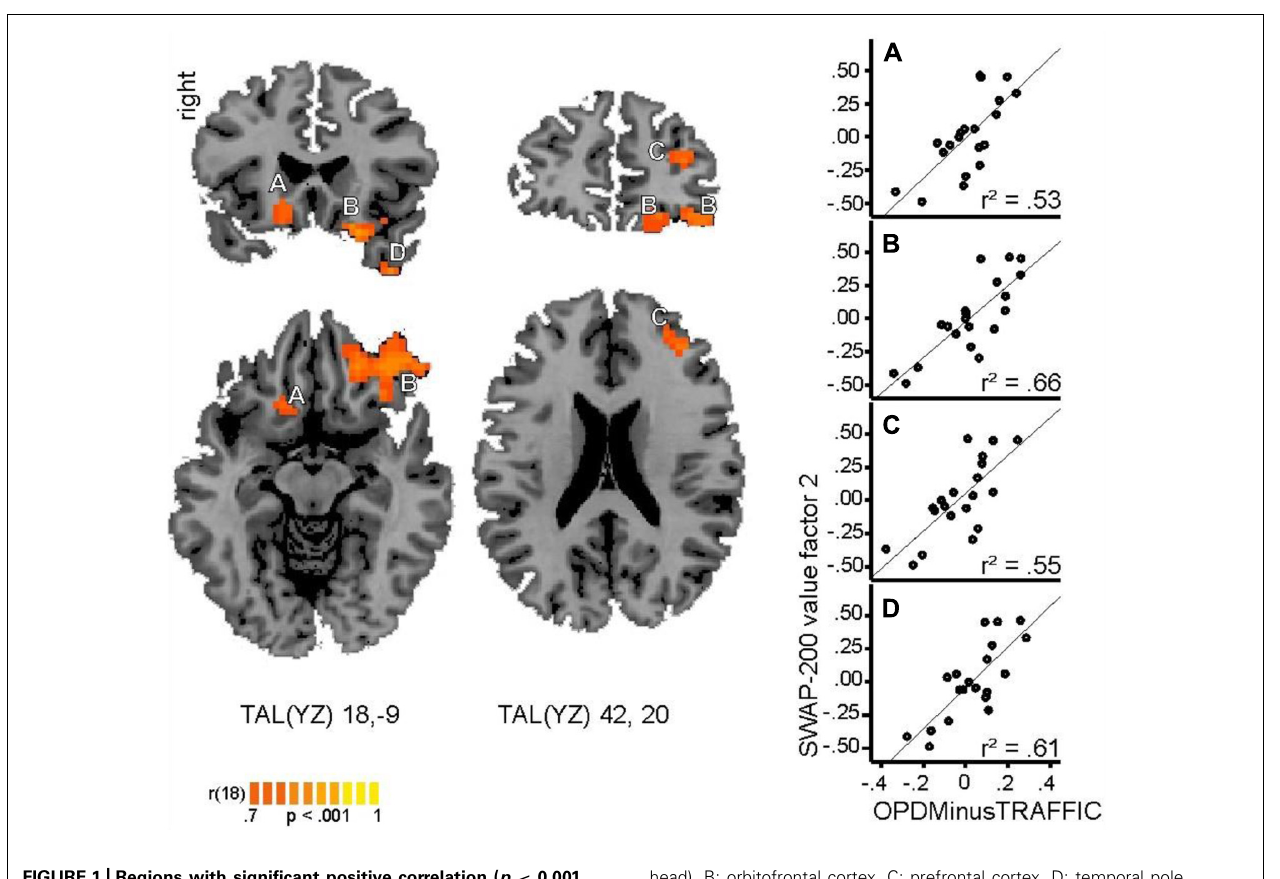
head), B: orbitofrontal cortex, C: prefrontal cortex, D: temporal pole. Coordinates are provided in Talairach space. Right side: correlation coefficients between beta values within each cluster and SWAP-200 values for Factor